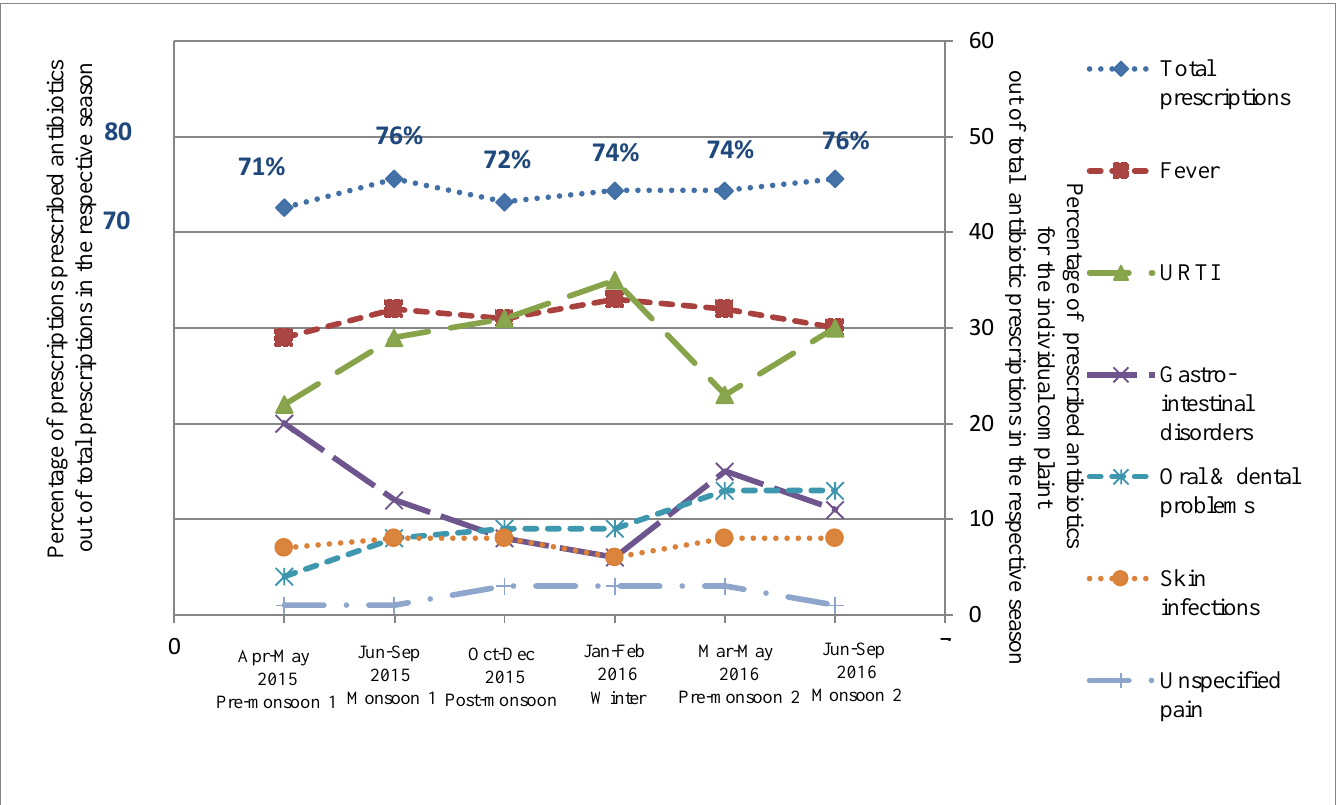
Figure 1. Relative distribution of proportion of prescribed antibiotics out of the total prescriptions in the respective seasons and percentage ofprescribed antibiotics for the individual complaint out of the total antibiotic prescriptions in the respective seasons in rural Ujjain, India. X axis represents the seasons (April – May 2015 Pre-monsoon 1, June – September 2015 Monsoon 1, October – December 2015 Post-monsoon, January – February 2016 Winter, March – May 2016 Pre-monsoon 2, June – September 2016 Monsoon 2); Primary Y axis on left represents the percentage of prescribed antibiotics out of total prescriptions in the respective season and secondary Y axis on right represents the percentage of prescribed antibiotics for the individual complaints (Fever, URTI — Upper respiratory tract infection, Gastro-intestinal disorders, Oral and dental problems, Skin infections, and Unspecified pain) out of the total antibiotic prescriptions in the respective seasons.